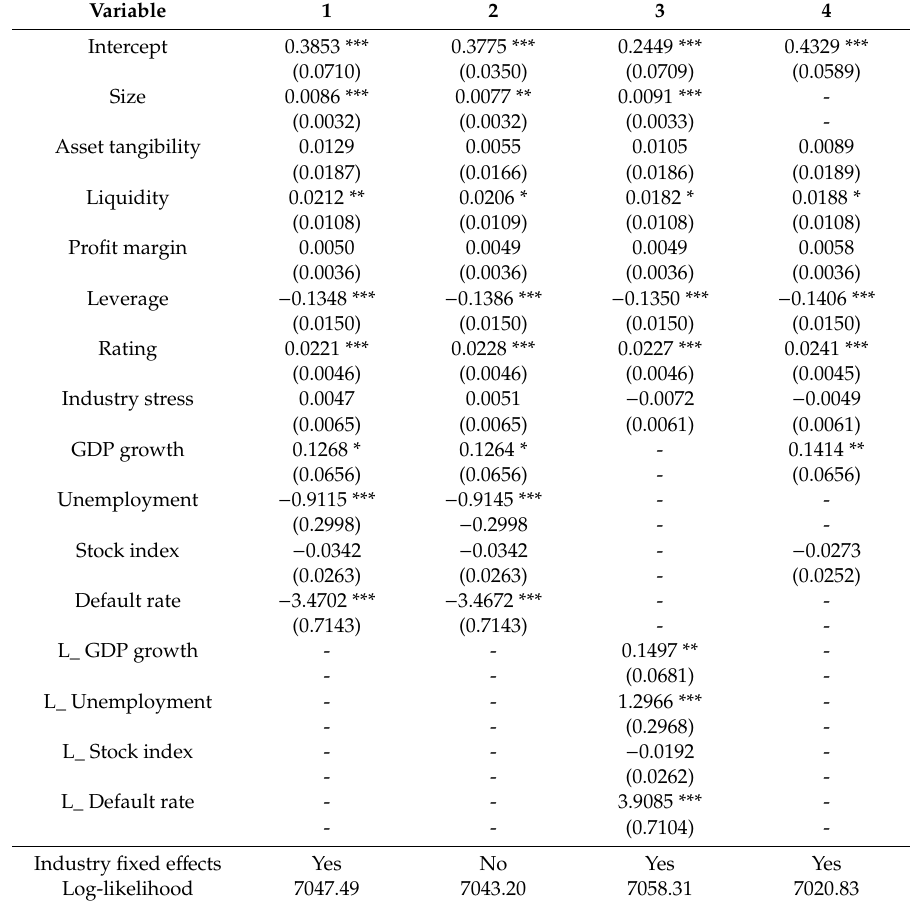
Table 9. Tobit regression results for the level of market-implied recovery rates. Robust standard errors are reported in parentheses. Variables preceded by “L_” are lagged by one quarter. Statistical significance at the 10%, 5% and 1% level is indicated by superscript *, ** and ***,